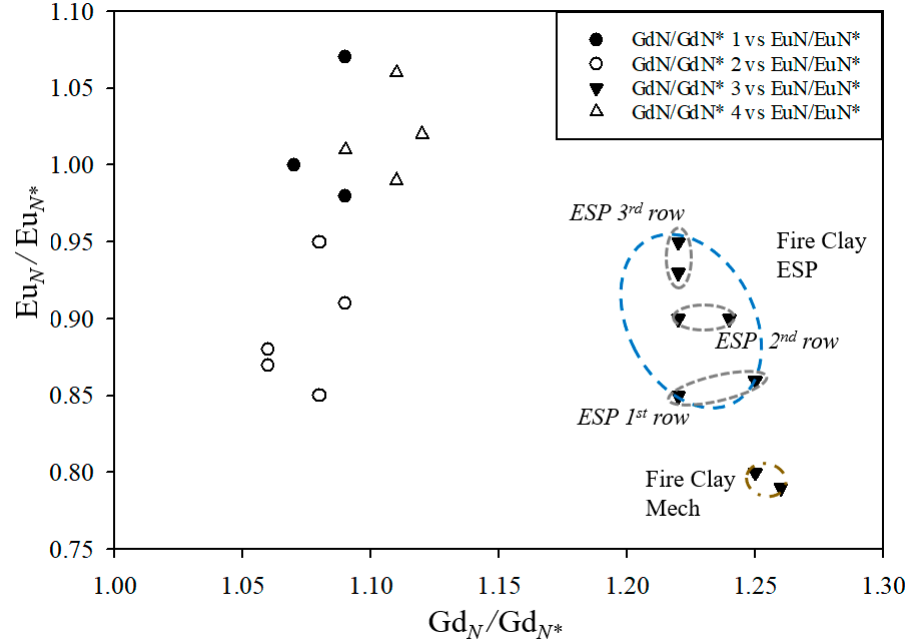
Figure 6. Eu N /Eu N * vs. Gd N /Gd N * for all of the samples.